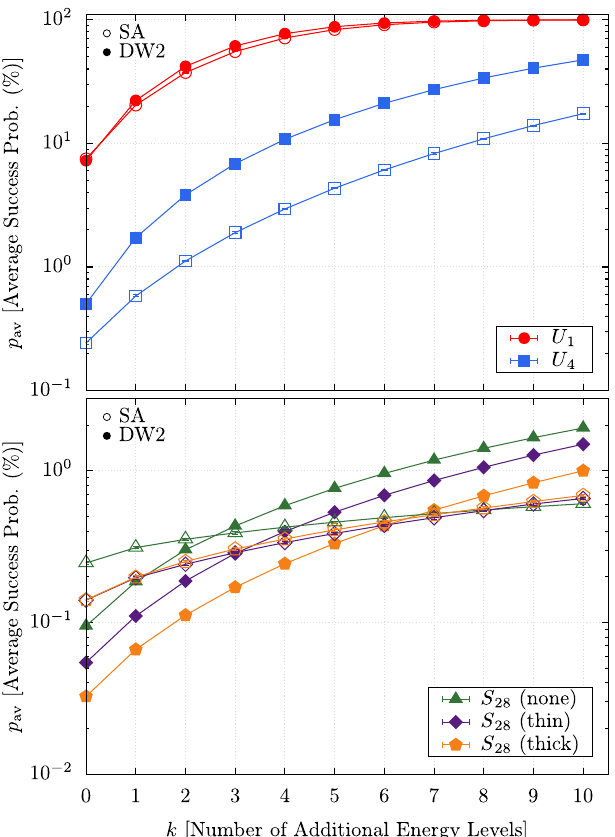
FIG. 6. Average success probabilities p (after a gauge av average) for both DW2 and SA as a function of the number k of low-lying energy levels above the ground state for different instance classes. The top panel shows data for the U 1 and U 4 instance classes, whereas the bottom panel shows data for the S 28 class. Both panels have the same horizontal axis; we split up the data for better viewing. The trend displayed by DW2 compared to the SA codes for the S 28 class suggests that noise might be the dominant source of the overall poor performance of the DW2